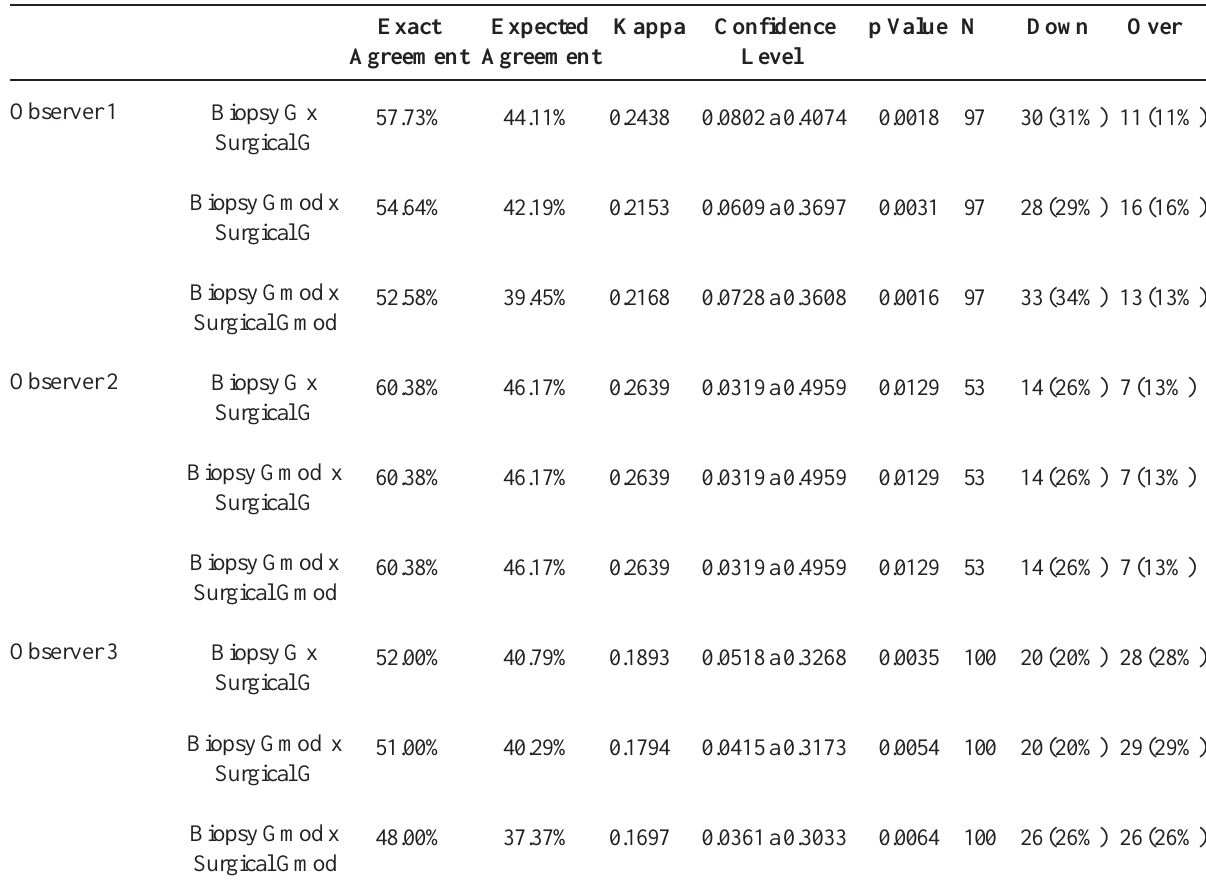
Table 4 – Agreement between traditional and modified Gleason scores in needle biopsies and surgical specimens according to observers. considering each patient as an independent event. Number of needle biopsies whose Gleason score was downgraded or upgraded in relation to the surgical specimen.